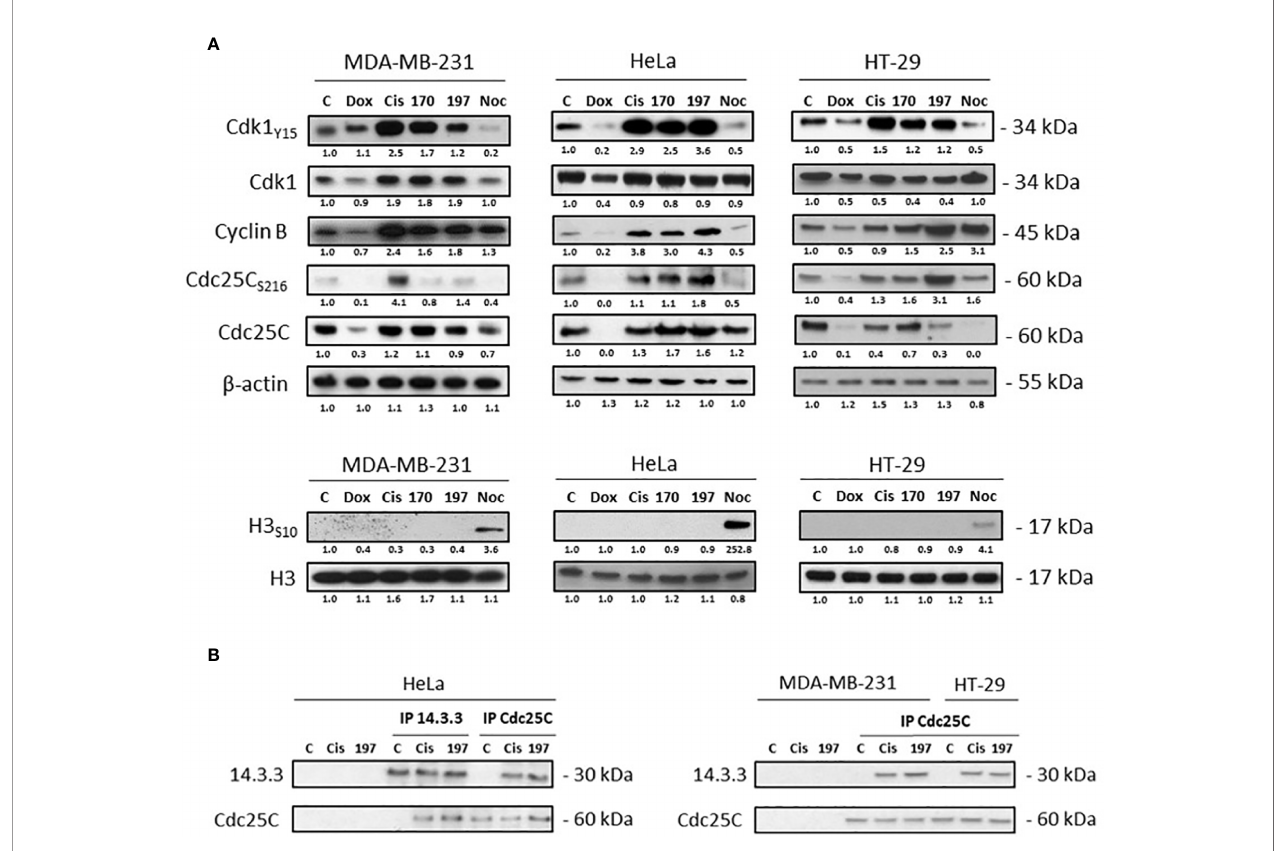
FIGURE 6 | WN197 arrested the cell cycle in G2. (A) Western Blot analysis of cells treated for 24 h with doxorubicin (5 µM), cisplatin (20 µM), WN170, WN197 (0.5 µM), or nocodazole (84 nM). b -actin was used as a loading control. For H3 phosphorylation, respective H3 total levels were used as loading controls. (B) 14-3-3 and Cdc25C immunoprecipitations were realized in cell lines treated for 24 h with cisplatin (20 µM) or WN197 (0.5 µM). Relative protein levels were expressed by densitometry using Image J software (Fiji Software, v1.52i). Results were representative of three independent